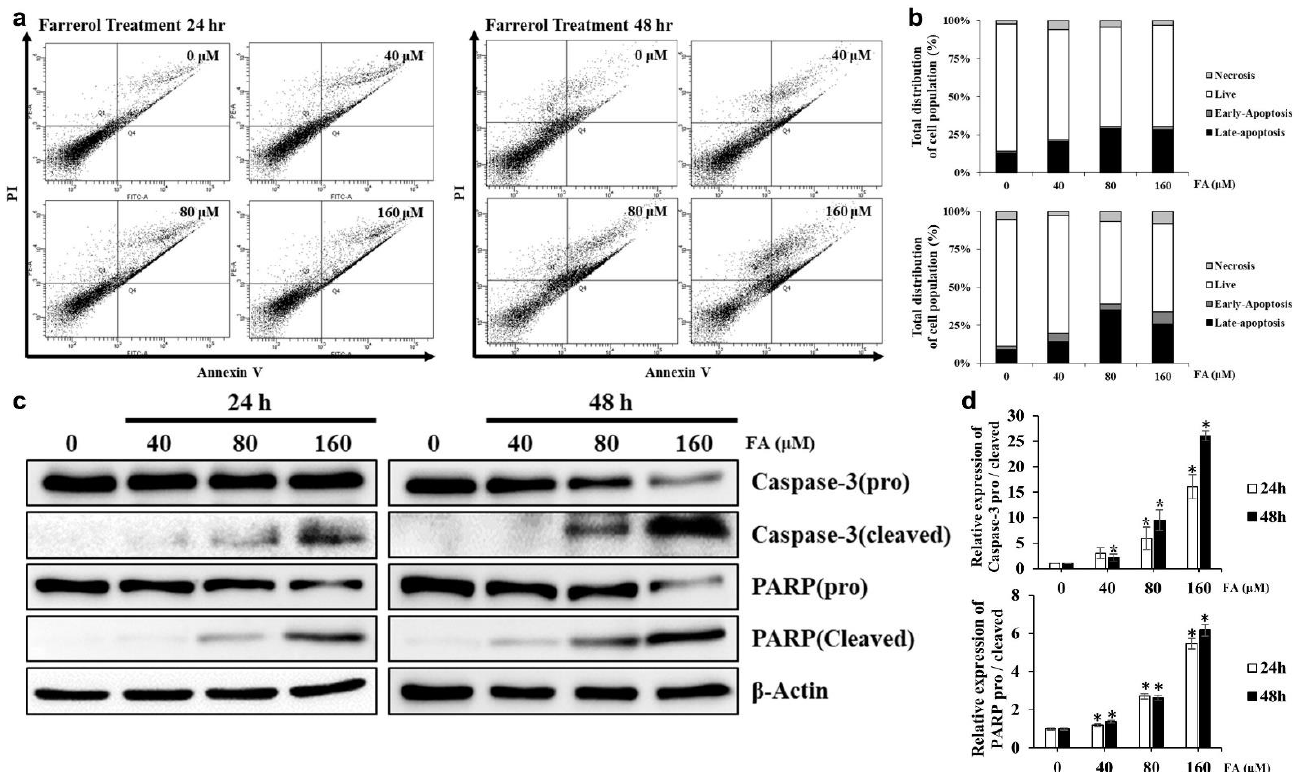
Figure 4. Effect of farrerol (FA) on the induction of apoptosis in SKOV3 cells. ( a ) SKOV3 cells were treated with the indicated concentration of FA for 24 or 48 h. Apoptotic cells were detected using a Annexin V-FITC/PI staining assay. ( b ) Quantification of apoptotic cell ratio of Annexin V/PI staining assay. ( c ) SKOV3 cells were treated with FA for 24 or 48 h. The cells were lysed and total proteins were separated by SDS-PAGE. Equal loading was confirmed by the quantification of β -actin. ( d ) Representative images of western blots. Data are means ± SD from three independent experiments (*, p < 0.05).